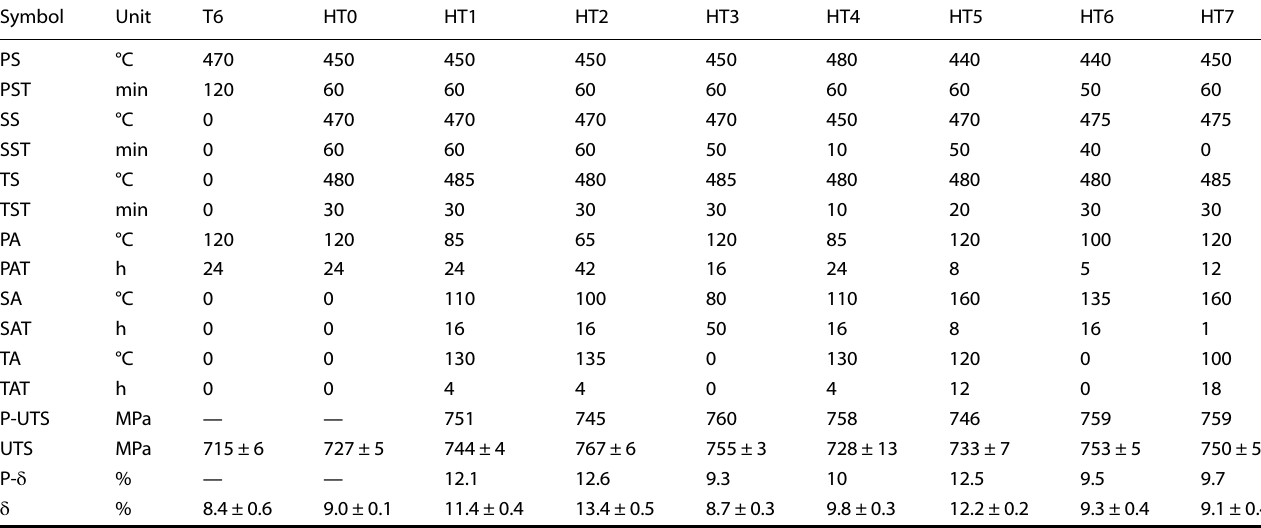
The results of T6 and HT0 treatments are listed for comparison. PS Primary solution temperature, PST Primary solution time, SS Secondary solution temperature, SST Secondary solution time, TS Tertiary solution